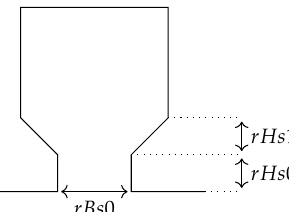
Figure 4. Optimized rotor slot dimensions of WRSG to minimize the torque ripple. Table 2. Comparison between the optimized and base WRSG for minimizing the torque ripple. Parameter